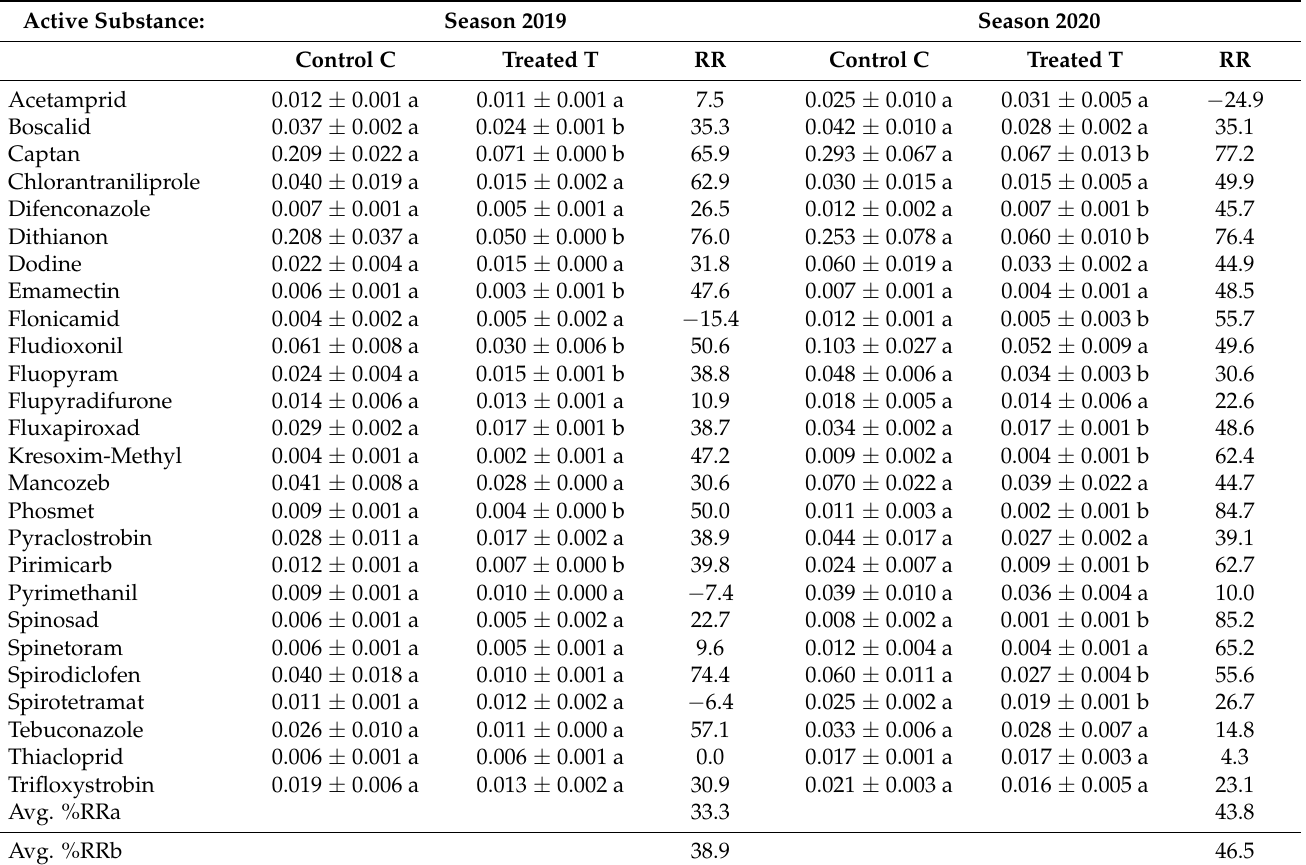
Table 5. Average concentration of pesticide residues ( ± SE) in apples at picking times (mg kg − 1 ) in relation to treatment with LDC; four times preharvest at a rate of 10 L of LDC ® /1000 L